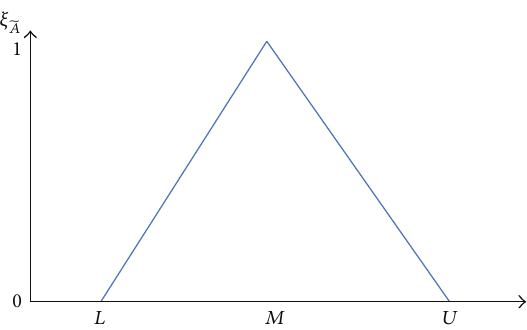
Figure 2: Fuzzy input membership function (the triangular mem- bership